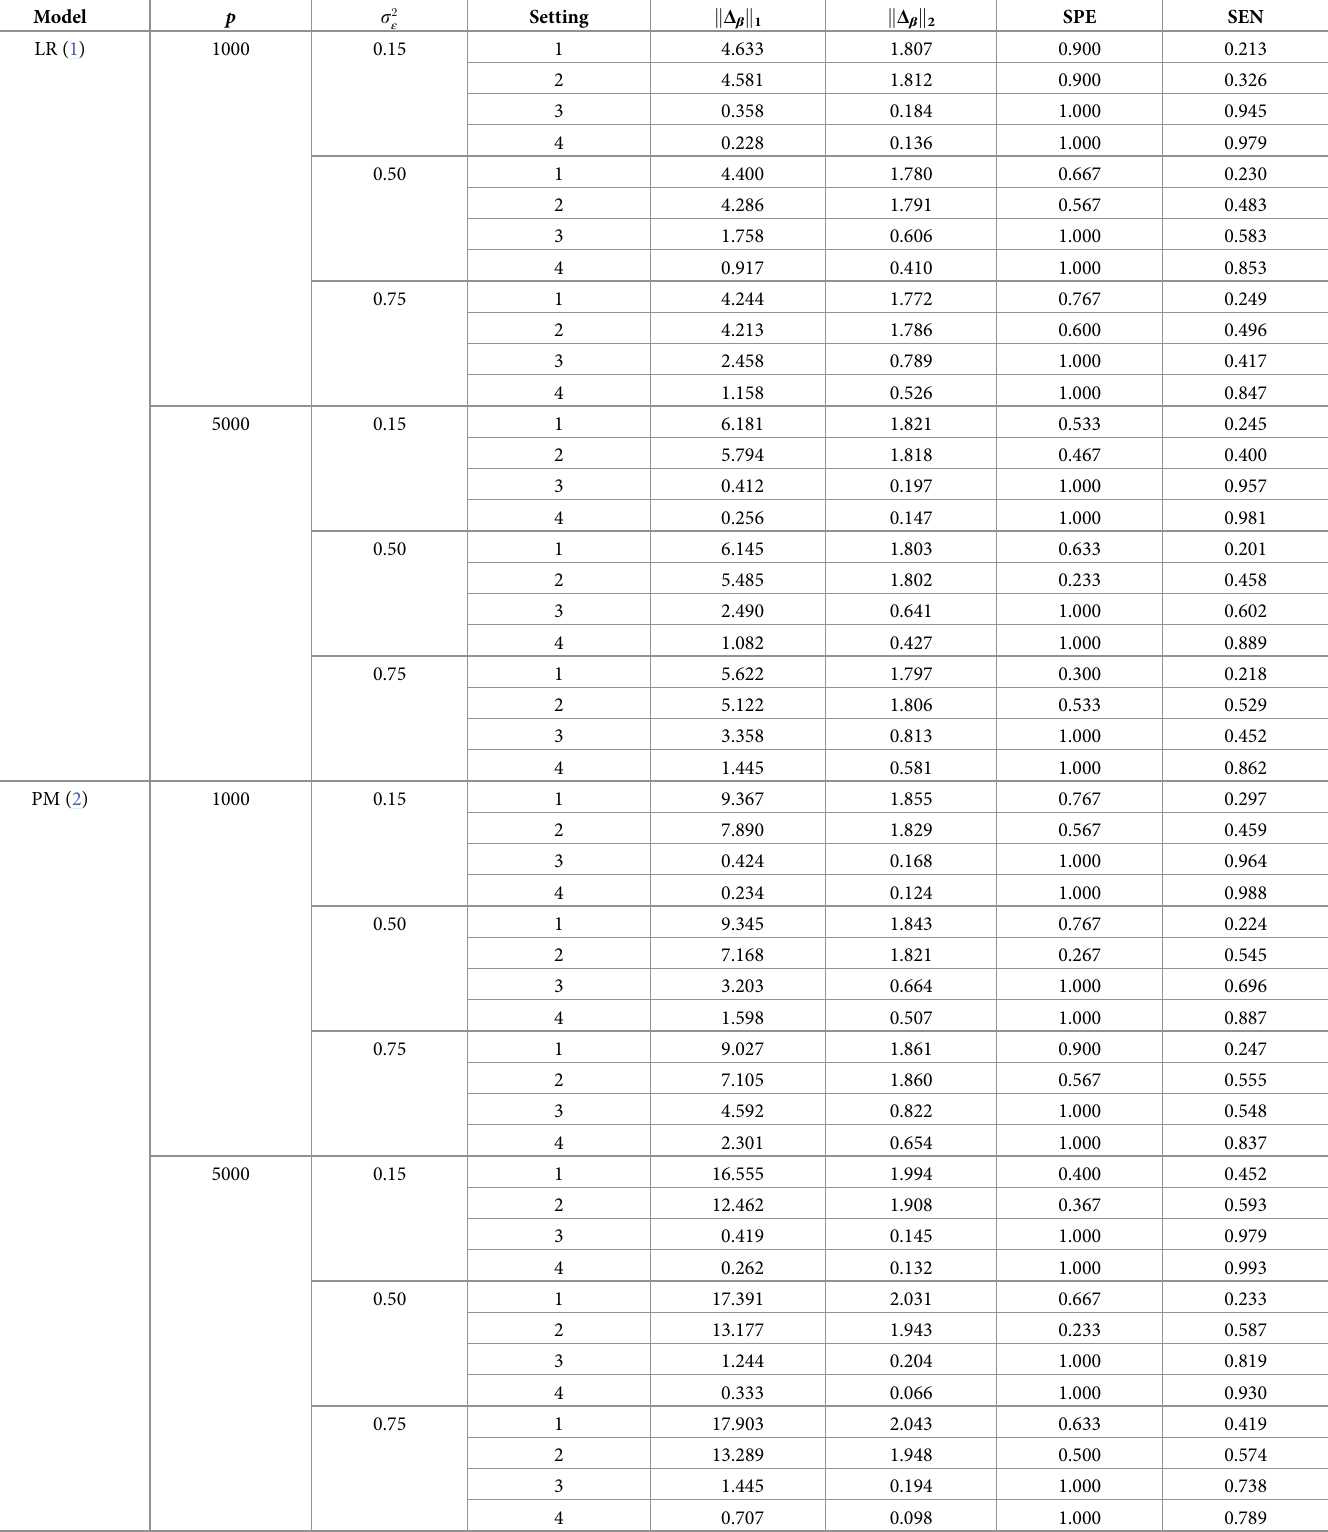
Table 4. Simulation results for two regression models with n = 100.